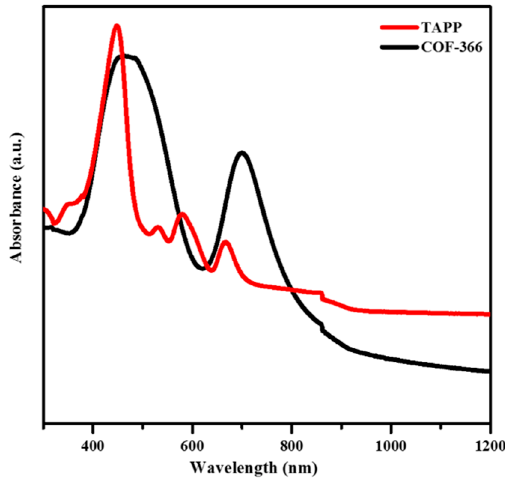
Figure 5. UV–Vis spectra of TAPP and COF-366 film with 100 μ L